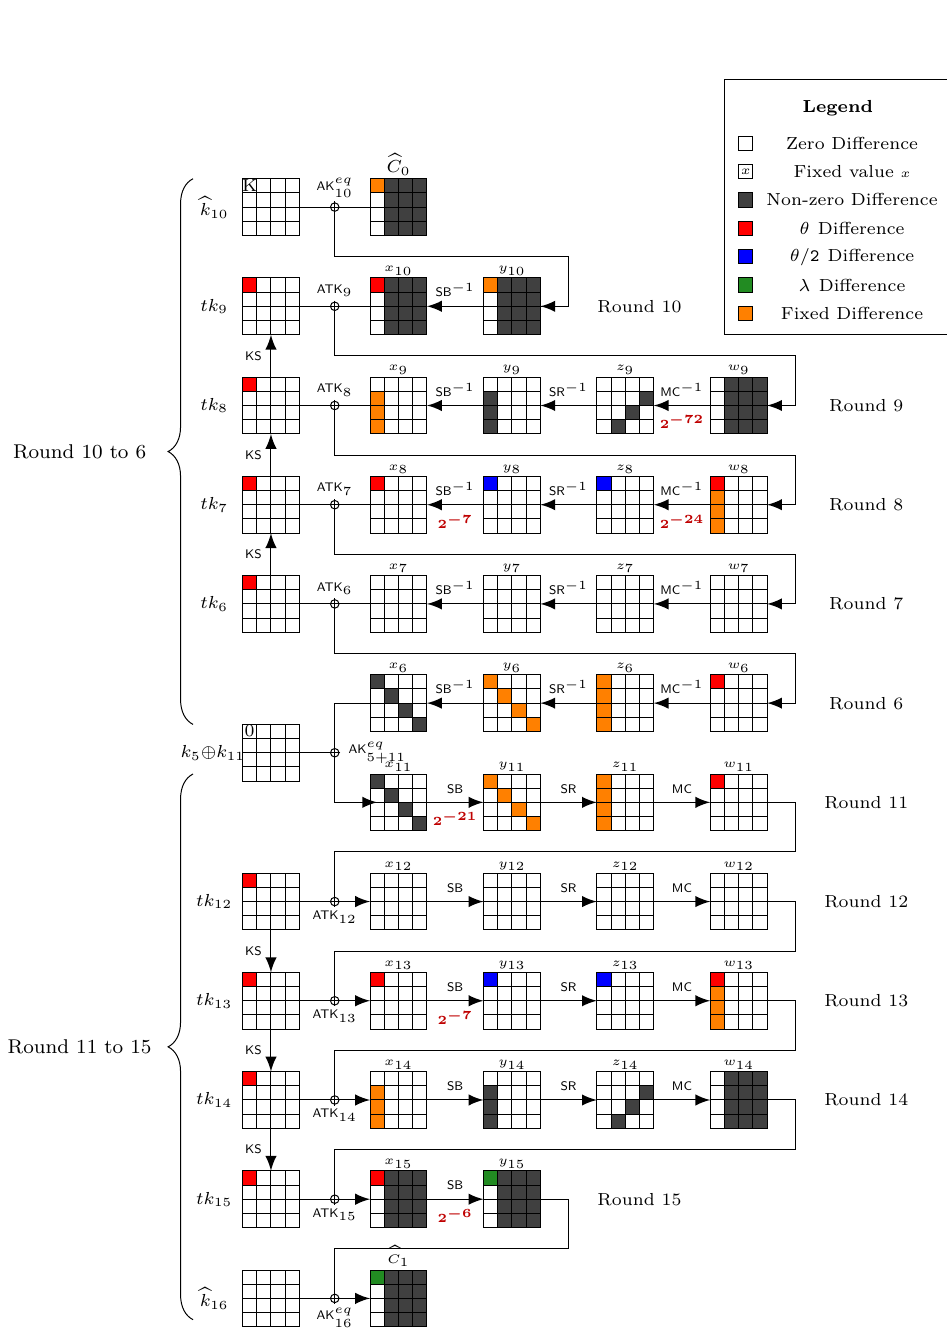
Figure 10: Differential characteristic for 2 119 weak